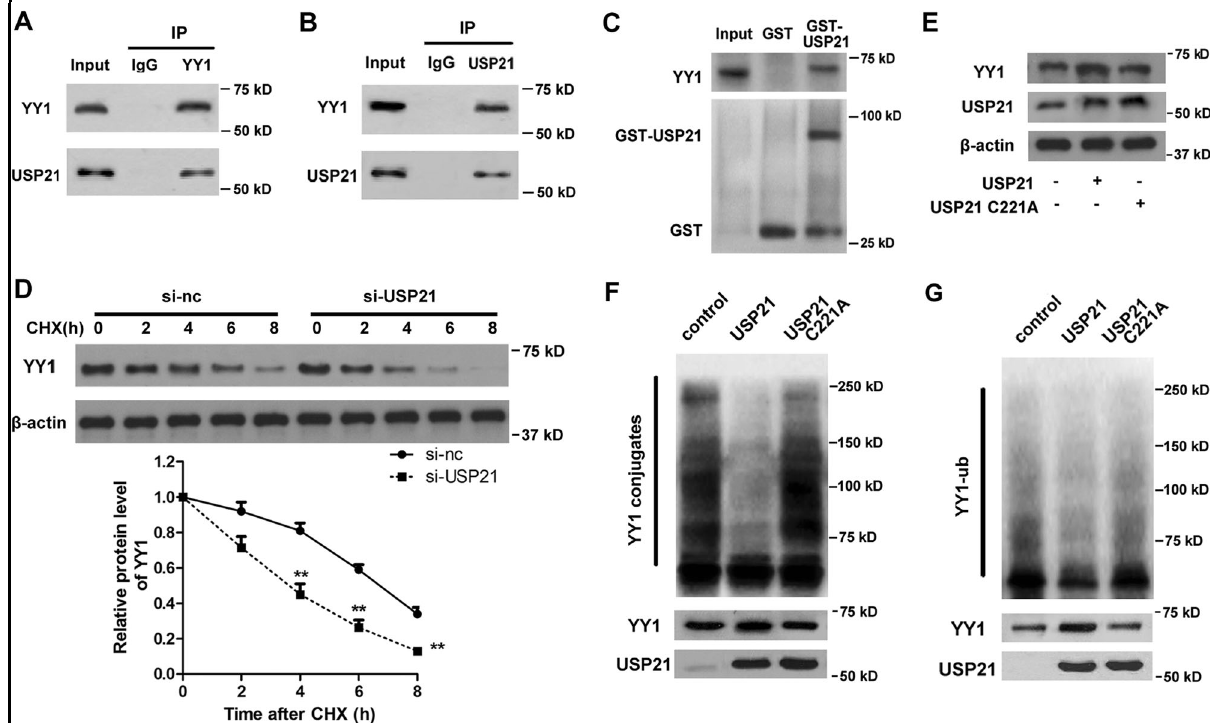
Fig. 5 USP21 deubiquitinates YY1 in lung cancer cells. a , b The cell lysates from A549 cells were used in immunoprecipitation experiments with an anti-YY1 ( a ) or an anti-USP21 antibody ( b ) and immunoblotted with anti-YY1 and anti-USP21 antibodies, respectively. c GST pull-down analysis was used to determine whether USP21 directly interacted with YY1 in vitro. d Western blot analyses of YY1 expression in A549 cells transfected with the indicated plasmids and treated with cycloheximide. Quanti fi cation of YY1 protein levels relative to β -actin is shown. e Expression of YY1 in the presence of wild-type (wt) or a mutated version of USP21. β -Actin was used as an internal control. f Western blot analyses of YY1 conjugates. g Western blot analyses of ubiquitinated proteins. Statistical signi fi cance was determined by a two-tailed, unpaired Student ’ s t test. Error bars: mean ± SD. n = 3. ** p <